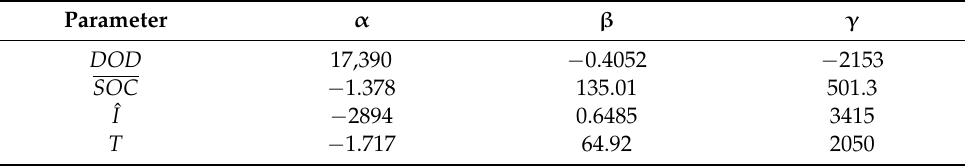
Figure 3. Influence of the normalized battery current: ( a ) number of cycles and ( b ) f Δ SOH,I . Table 1. Values for tuning coefficients of models of lithium-ion degradation impact factors. Parameter